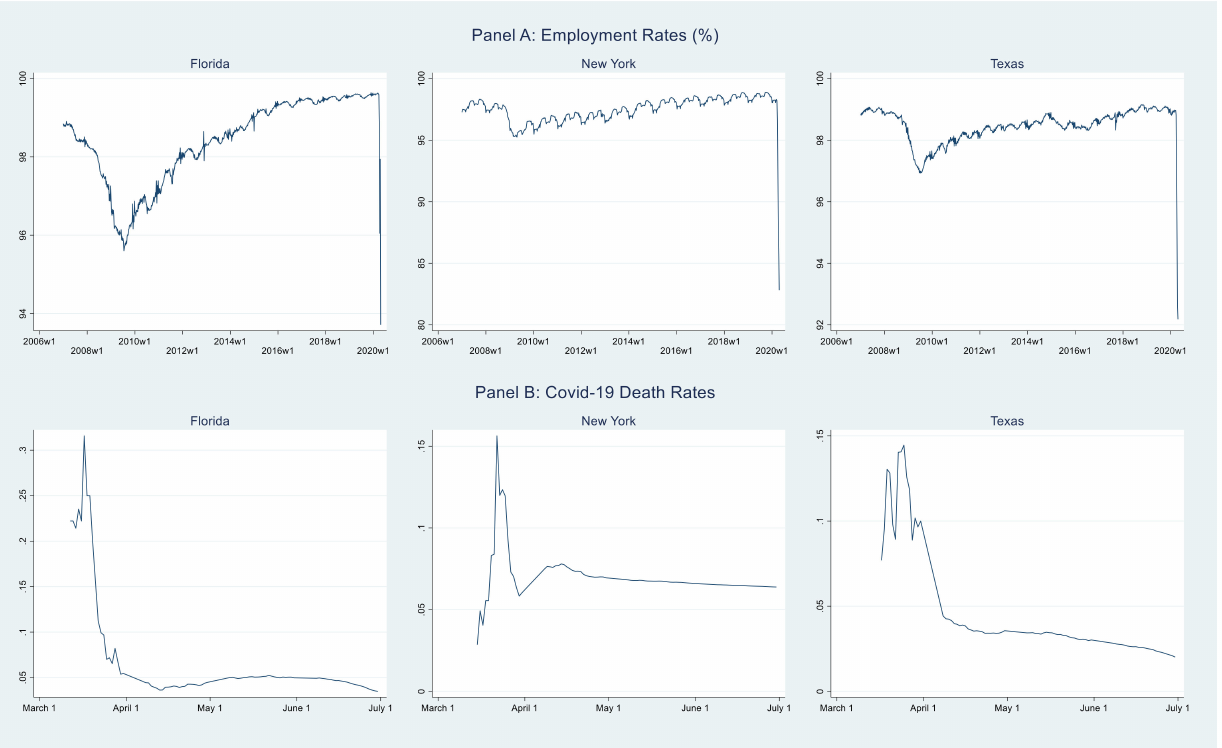
Figure 1. Weekly employment rates (2006–2020) and daily COVID-19 death rates (2020) by